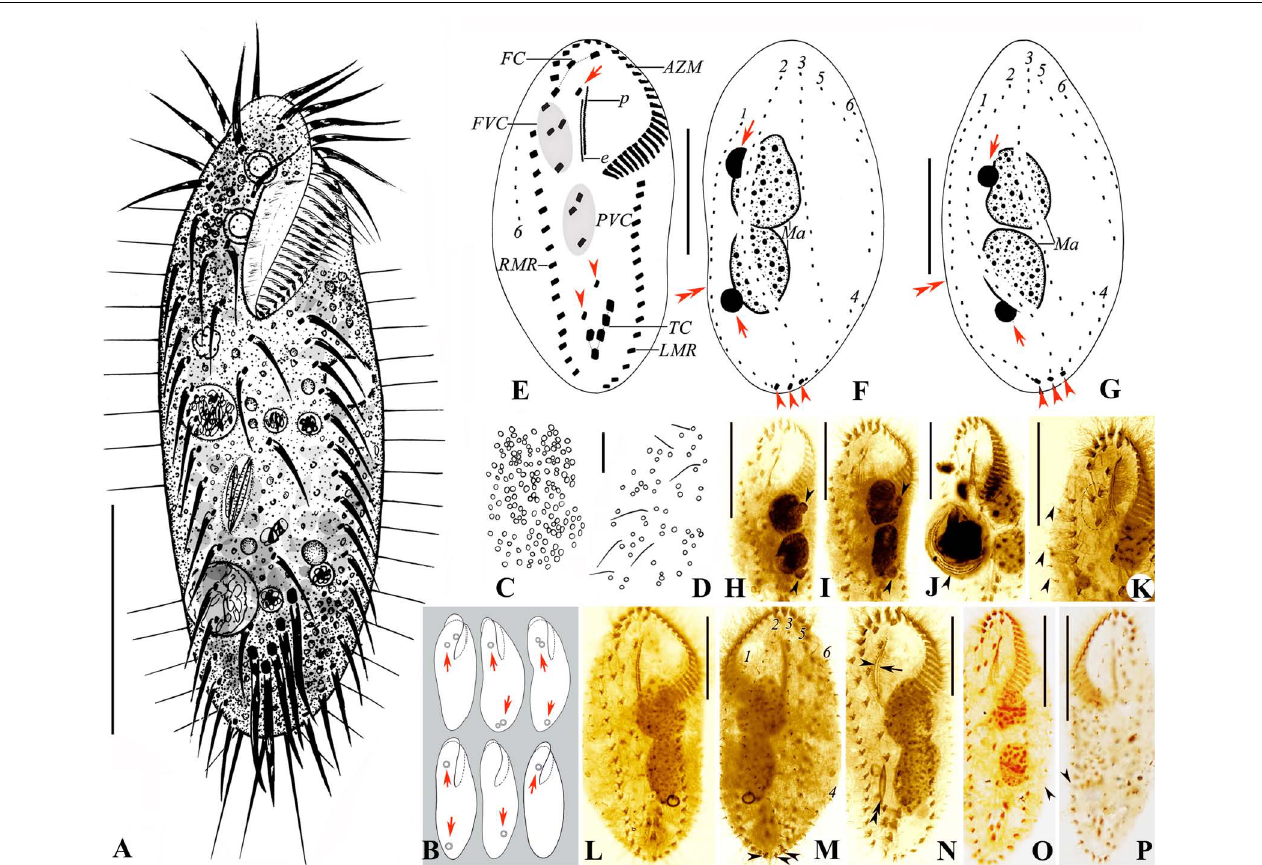
FIGURE 2 | (A–P) Morphology and ciliature of the Zhuhai population of Oxytricha lithofera from life (A–D) and after protargol impregnation (E–P) . (A) Ventral view of a representative individual. (B) Ventral views, showing body shape and lithosomes (arrows). (C,D) Distribution of cortical granules on the ventral (C) and dorsal (D) side. (E–G) Ventral (E) and dorsal (F,G) views of representative specimens, showing ciliature and nuclear apparatus; arrowheads in (E) mark pretransverse ventral cirri; arrow in ( E ) indicates buccal cirrus; arrowheads in (F,G) mark caudal cirri; arrows in (F,G) indicate micronuclei; double arrowheads in (F,G) mark the indeed very indistinct gap in dorsal kinety 1. (H,I) Ventral views showing the abutting macronuclear nodules and the large micronuclei (arrowheads) attached to the macronuclear nodules. (J) Ventral view, showing a specimen with an ingested ciliate (arrowhead). (K) Ventral view of a specimen with three frontoventral cirri; arrowheads indicate the long dorsal bristles of dorsal kinety 6. (L,M) Ventral (L) and dorsal (M) views of a representative specimen, the same one as (E,F) ; arrowheads mark caudal cirri. (N) Ventral view, showing ciliature, the abutting macronuclear nodules, and an ingested diatom (double arrowheads); arrowhead indicates paroral membrane; arrow marks endoral membrane. (O,P) Show the slightly conspicuous one-bristle-wide gap in dorsal kinety 1. AZM, adoral zone of membranelles; e, endoral membrane; FC, frontal cirri; FVC, frontoventral cirri; LMR, left marginal row; Ma, macronuclear nodules; p, paroral membrane; PVC, postoral ventral cirri; RMR, right marginal row; TC, transverse cirri; 1–6, dorsal kineties. Scale bars = 30 µ m (A,E–P) and 10 µ m (C,D)